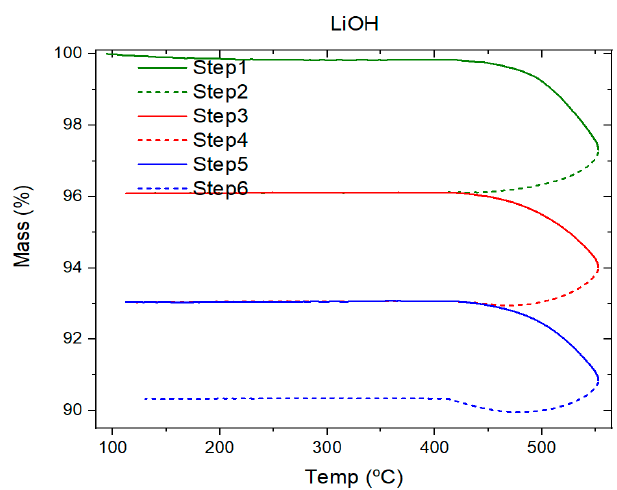
Figure 4. TGA curve for KOH between 100 and 500 ◦ C.